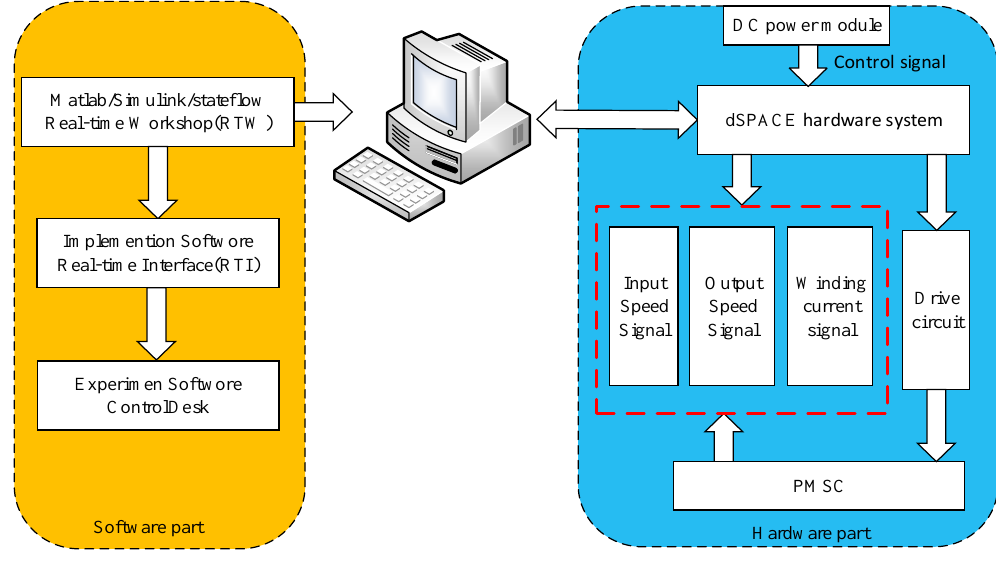
Figure 19. The rapid control prototype test platform of PMSC.